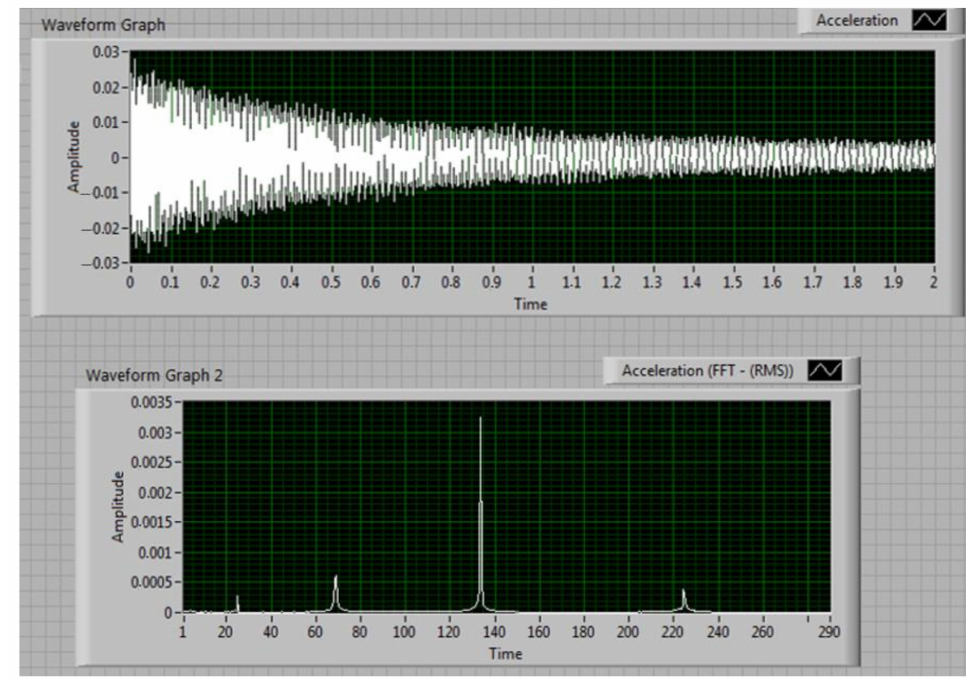
Figure 13. Mode no. 4 extracted signal for test beam